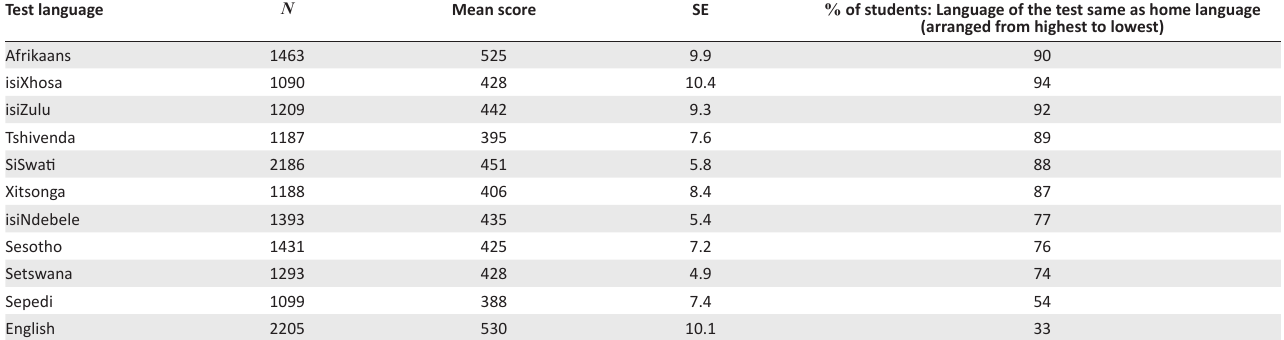
TABLE 3: prePIRLS 2011 achievement per language and percentage coincidence of home language and test language. Test